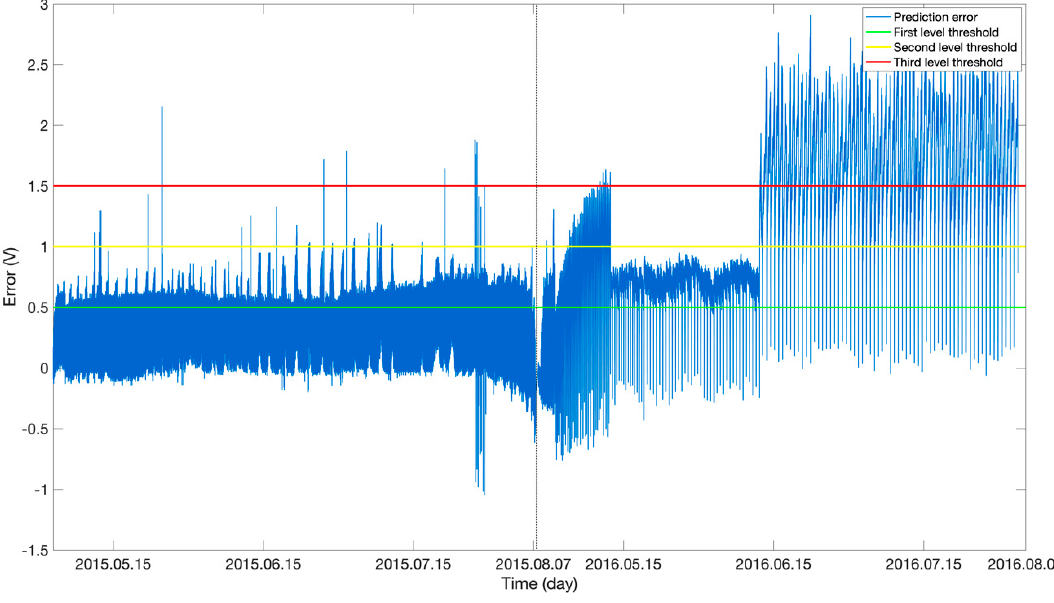
Figure 7. DBN-based prediction errors.